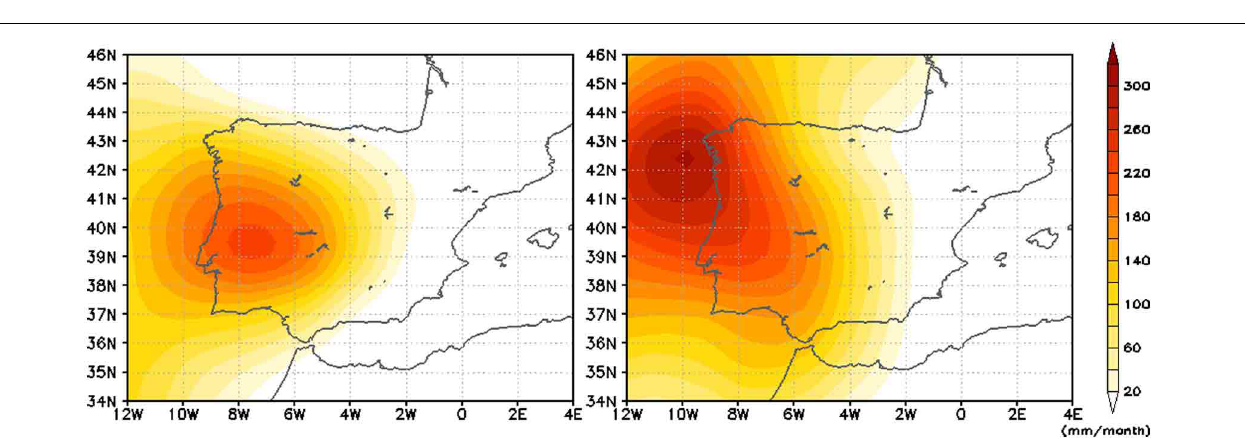
FIGURE 10 | Monthly precipitation anomaly from the 20CR for November (left) and December (right) 1876 (climatological normal for the period